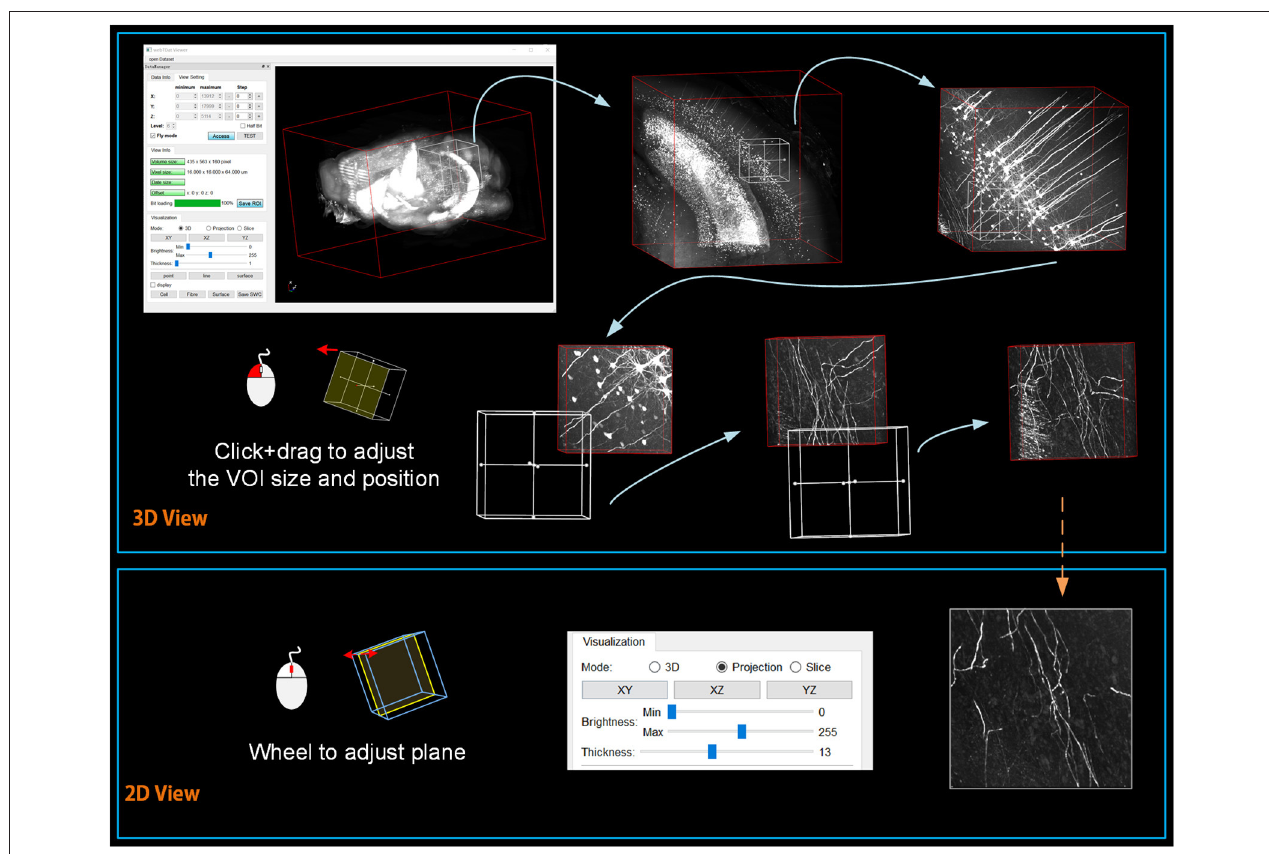
FIGURE 7 | The webTDat interface when interactively browsing whole-brain data. The interactive window can be slid throughout the entire data space to select VOIs, which can be displayed in 3D or 2D modes.